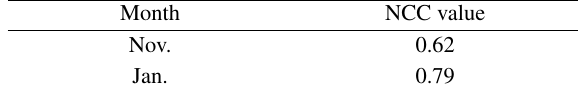
Table 16 NCC value between the English tweets (classified as self and nonself) and count of actual hospital visits.